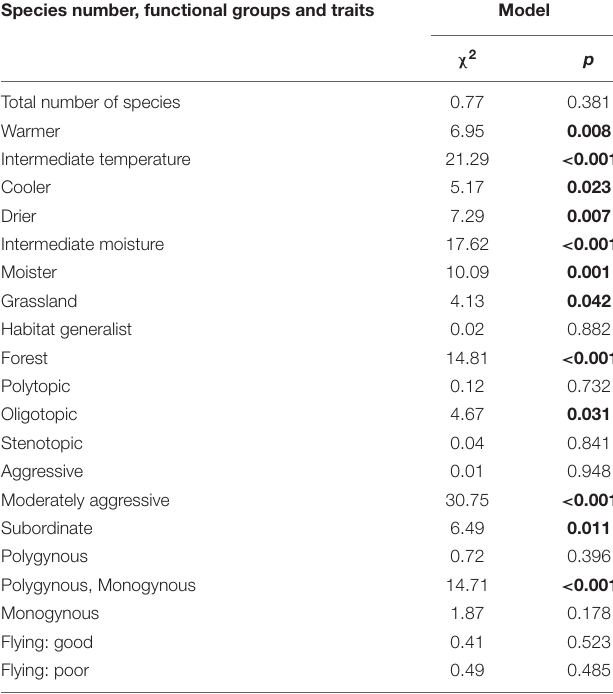
TABLE 2 | Comparisons of species numbers and ant species occurrences related to different functional groups and traits (see Figure 2 and Table 1 ) in different habitats (doline vs. plateau) in the Bükk Mts (Hungary) using the fitted generalized linear mixed-effect models. Species number, functional groups and